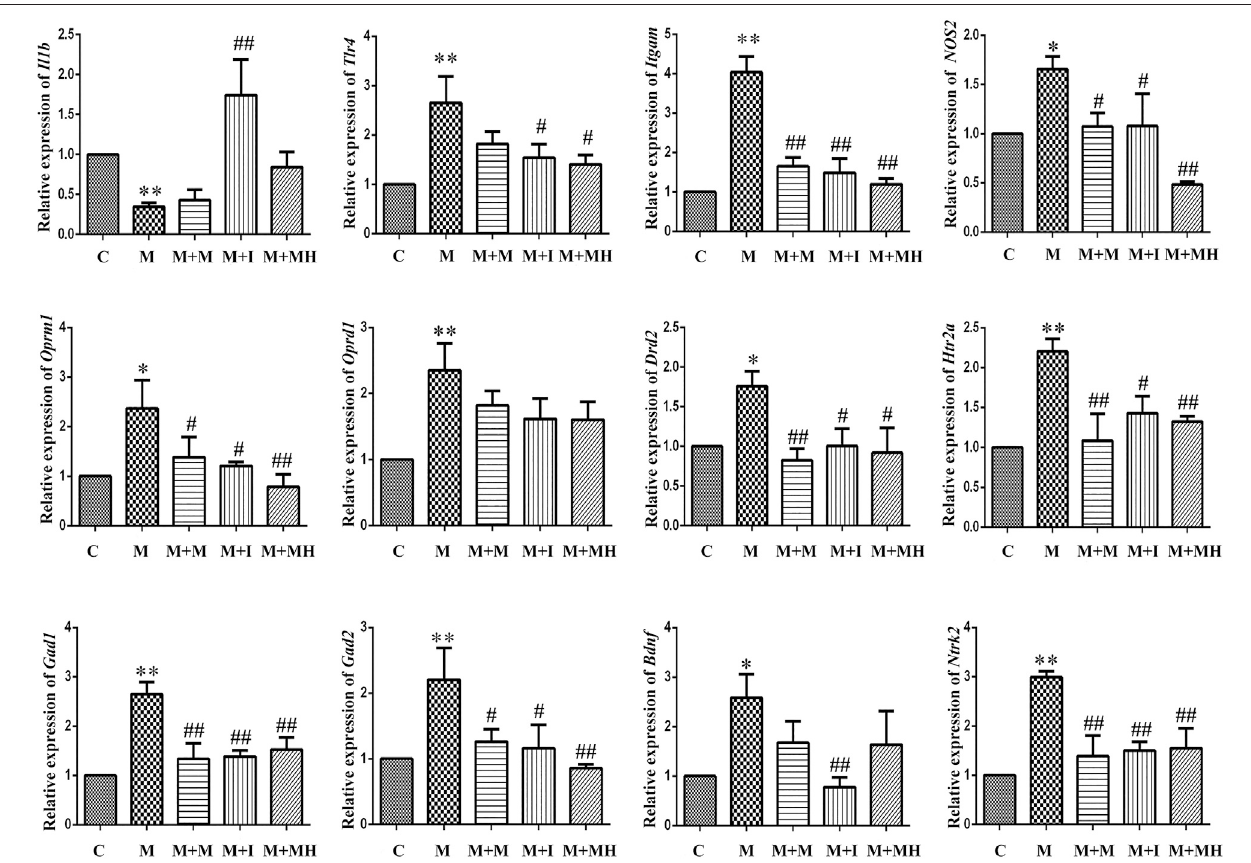
FIGURE 3 | qPCR analysis of Il1b , Tlr4 , Itgam , Nos2 , Oprm1 , Oprd1 , Drd2 , Htr2a , Gad1 , Gad2 , Bdnf , and Ntrk2 expression in BV2 cells ( n (cid:2) 3). * p < 0.05, ** p < 0.01 vs the C group; # p < 0.05, ## p < 0.01 vs the M group. C: control group; M: morphine group; M + M: morphine + methadone group; M + I: morphine + isorhynchophylline group; M + MH: morphine + minocycline hydrochloride